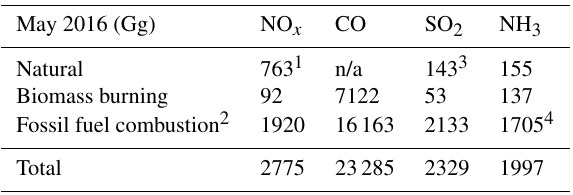
Table 2. KORUS-AQ emissions over the domain 15 ◦ S to 55 ◦ N, 70 ◦ to 140 ◦ E.